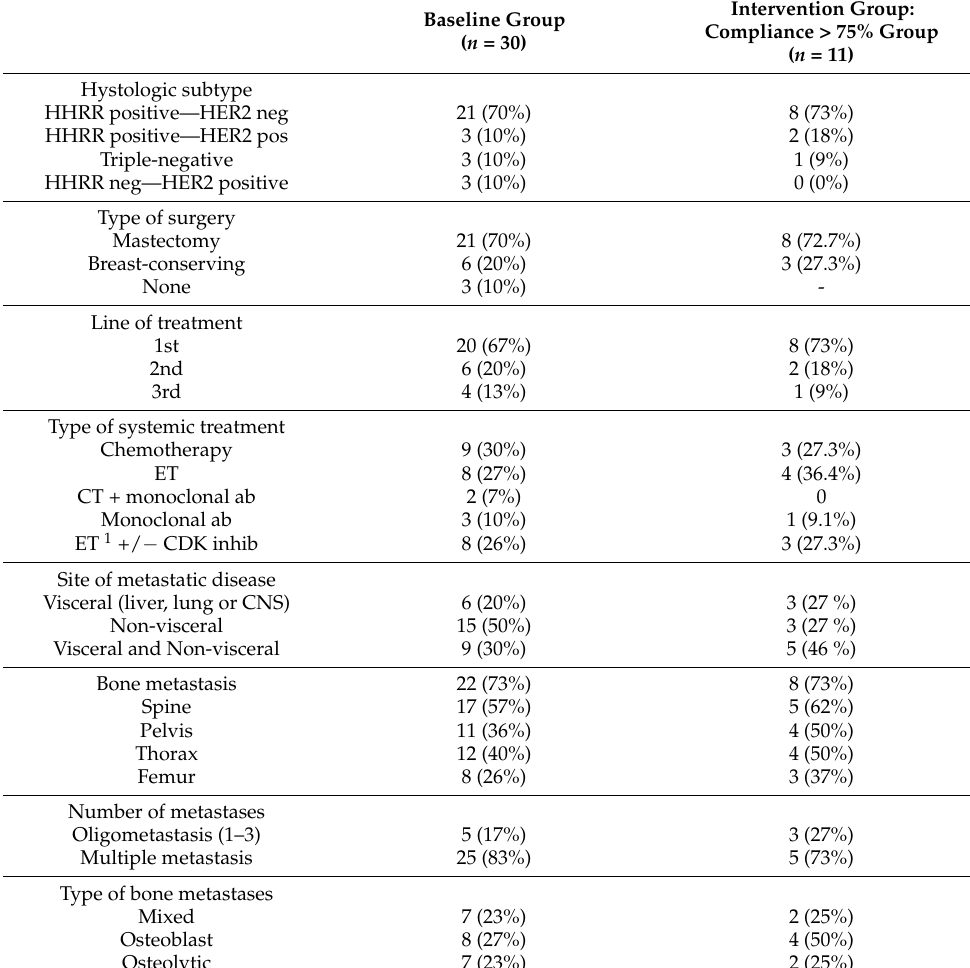
Table 2. Patients’ oncological characteristics at